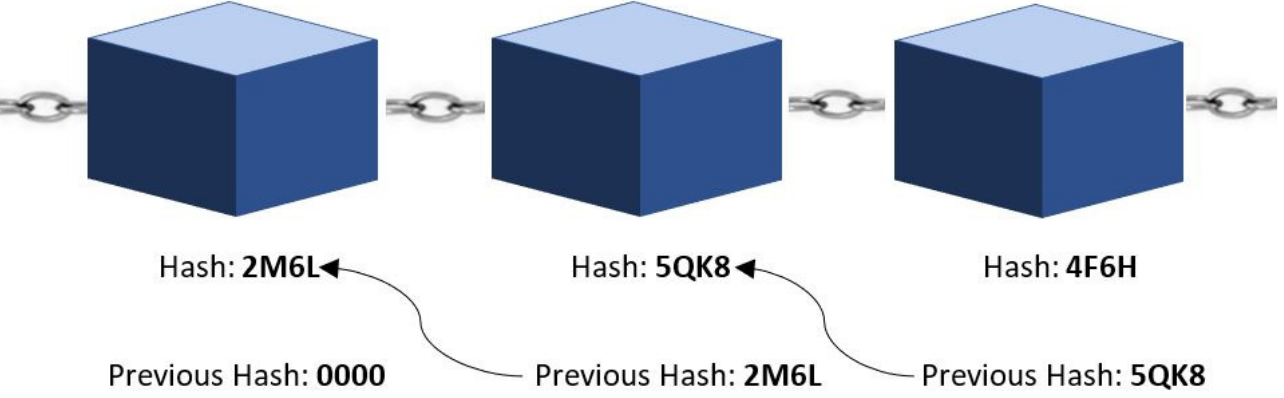
Figure 1. A structure of a blockchain consisting of linked blocks.